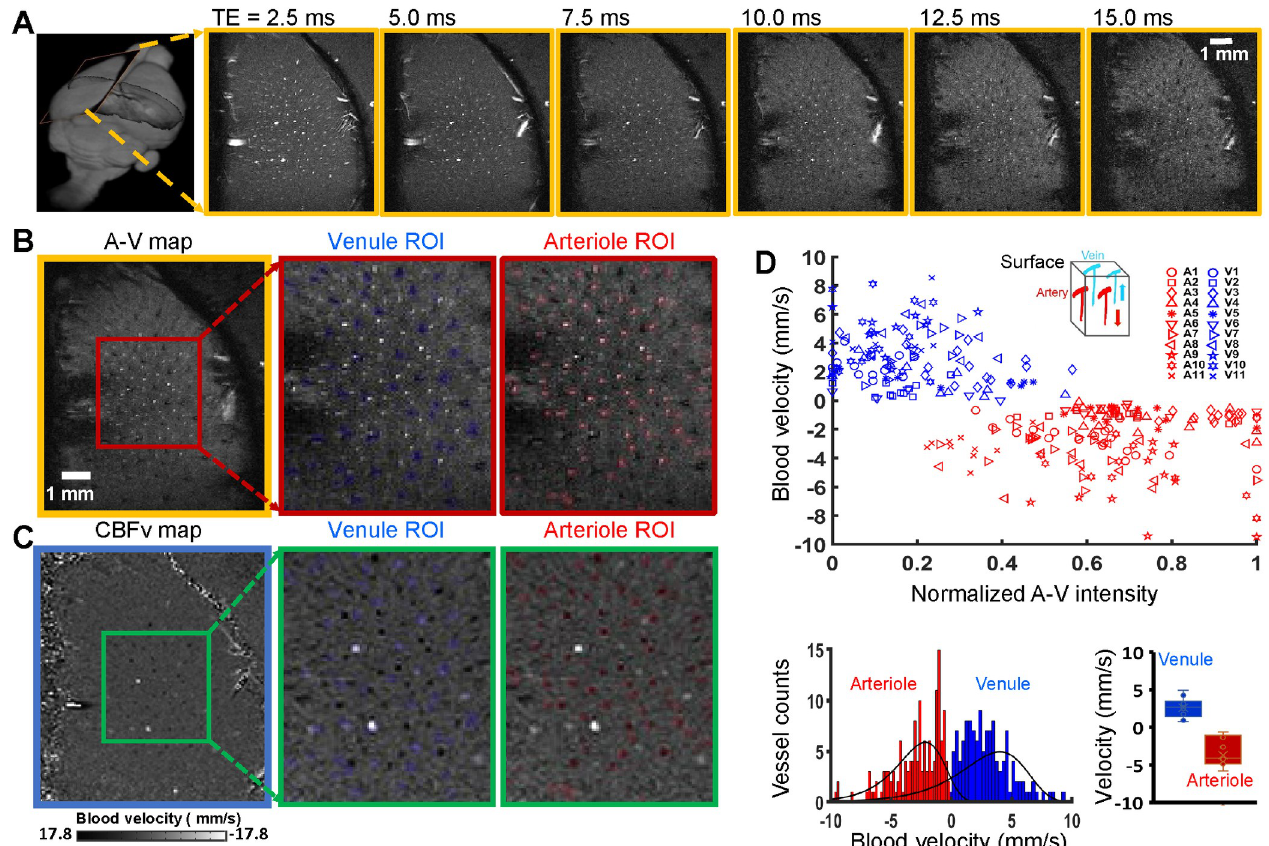
Fig 2. PC-based single-vessel flow velocity (CBFv) mapping. (A) Representative 2D MGE slices (yellow boxes) from a deep layer of the primary forepaw somatosensory cortex (first frame) at different TEs, as indicated. (B) The 2D A–V map (yellow box) derived from the images with different TEs in panel A, arterioles, and venules appear as bright and dark voxels, respectively. The expanded views (red boxes) show individual venules, i.e., black voxels marked in blue, and arterioles, i.e., white voxels marked in red. (C) The vectorized flow velocity map (blue box) from the same 2D MGE slice in panel B. The expanded views (green boxes) show the individual venules, i.e., white dots with positive velocity, and arterioles, i.e., black dots with negative velocity. Note that 2 bright dots are caused by the “overflowed” velocity beyond the maximal velocity, i.e., the Venc parameter, defined in the PC-MRI sequence, which could be not correctly estimated. (D) Scatter plot of the flow velocities from individual arterioles and venules as the function of the normalized signal intensities of each vessel in the A–V map of panel B, data from 11 rats as indicated. Insert shows the blood flow direction of arterioles and venules in the forepaw somatosensory cortical region. The lower panel shows the histogram of the blood velocity distribution across arterioles and venules, as well as the bar graph to show the mean velocity. The data underlying this figure can be found in S2 Data. A–V, arteriole–venule; CBFv, cerebral blood flow–related velocity; MGE, multi-gradient echo; PC, phase contrast; ROI, region of interest; Venc, velocity encoding; TE, echo time.